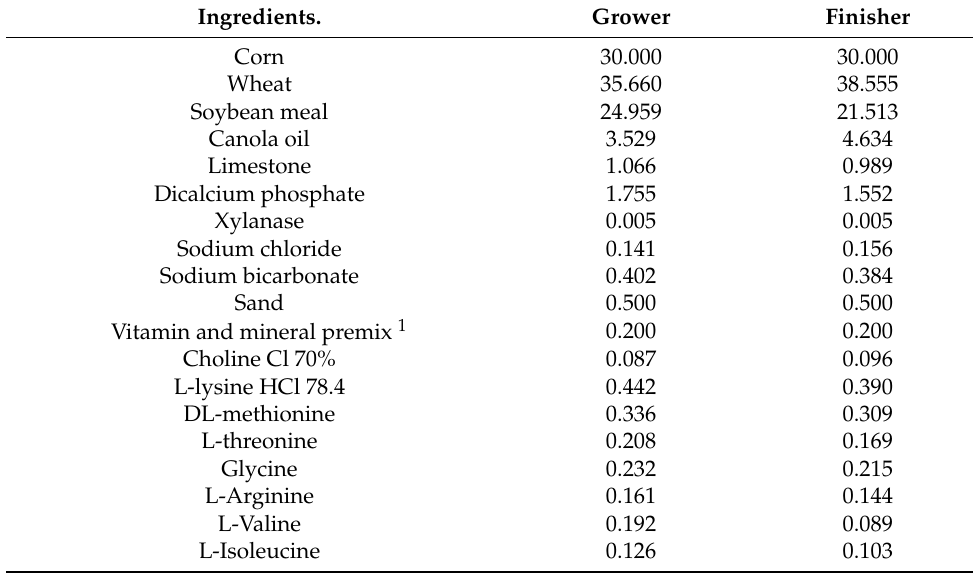
Table 1. Composition of basal experimental grower and finisher diets.